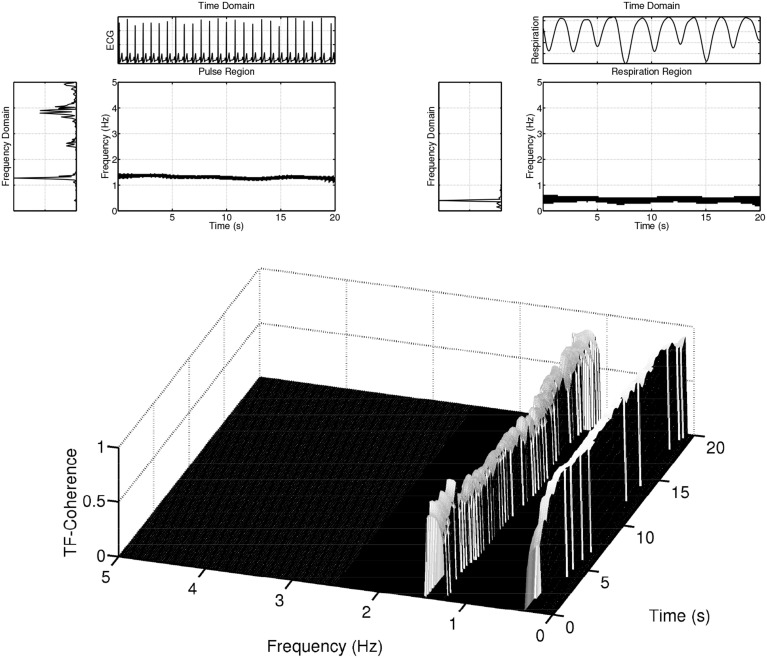
Example of coherences within delineated regions, i.e., the pulse and respiration regions, between ECG and respiration signals.